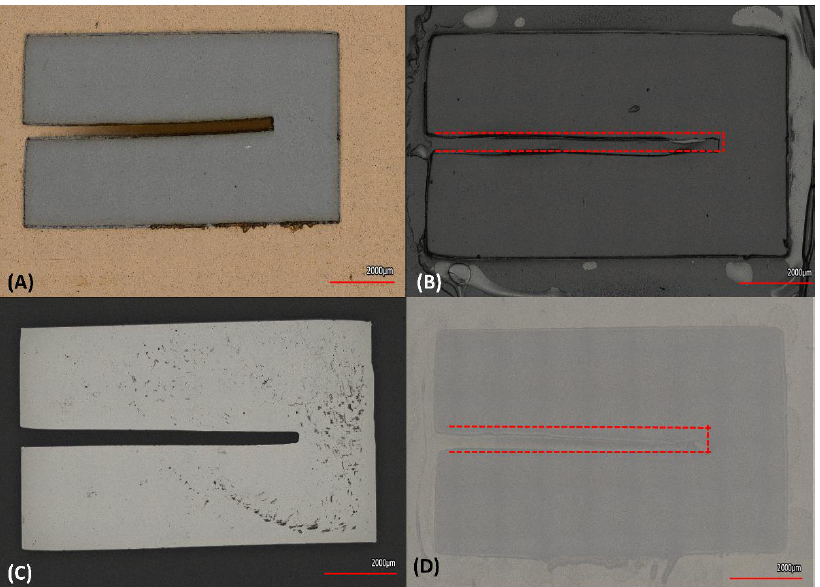
Figure 7. Square Channels depicting the smallest feature sizes for ( A ) Stencil Mask, ( B ) Gelatin, ( C ) Cr, ( D ) E. coli . ( C ) Cr, ( D ) E. coli